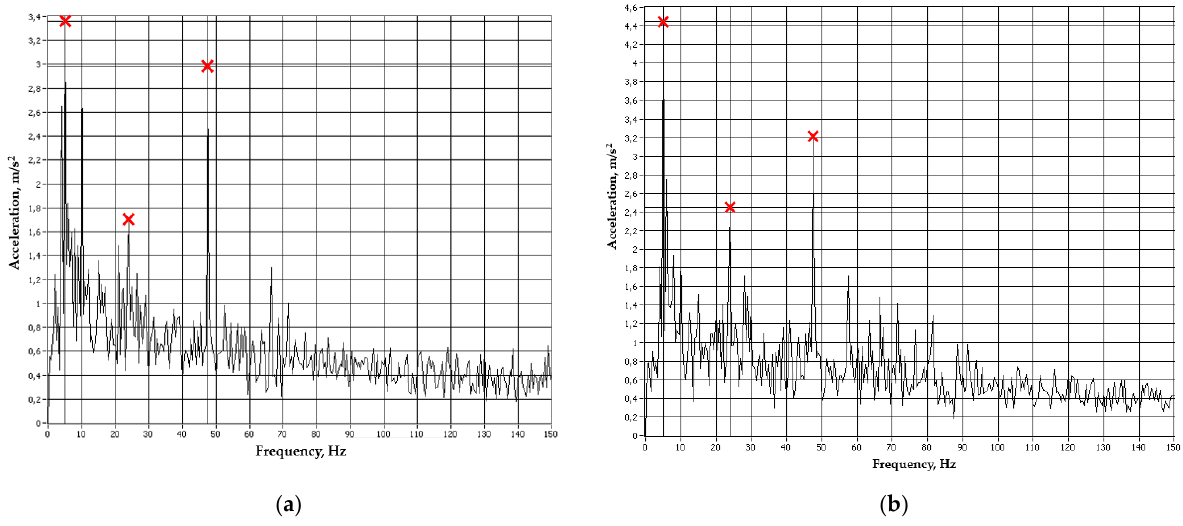
Figure 15. Comparison of vibration spectra of ( a ) healthy bearing and ( b ) bearing with damaged inner ring.